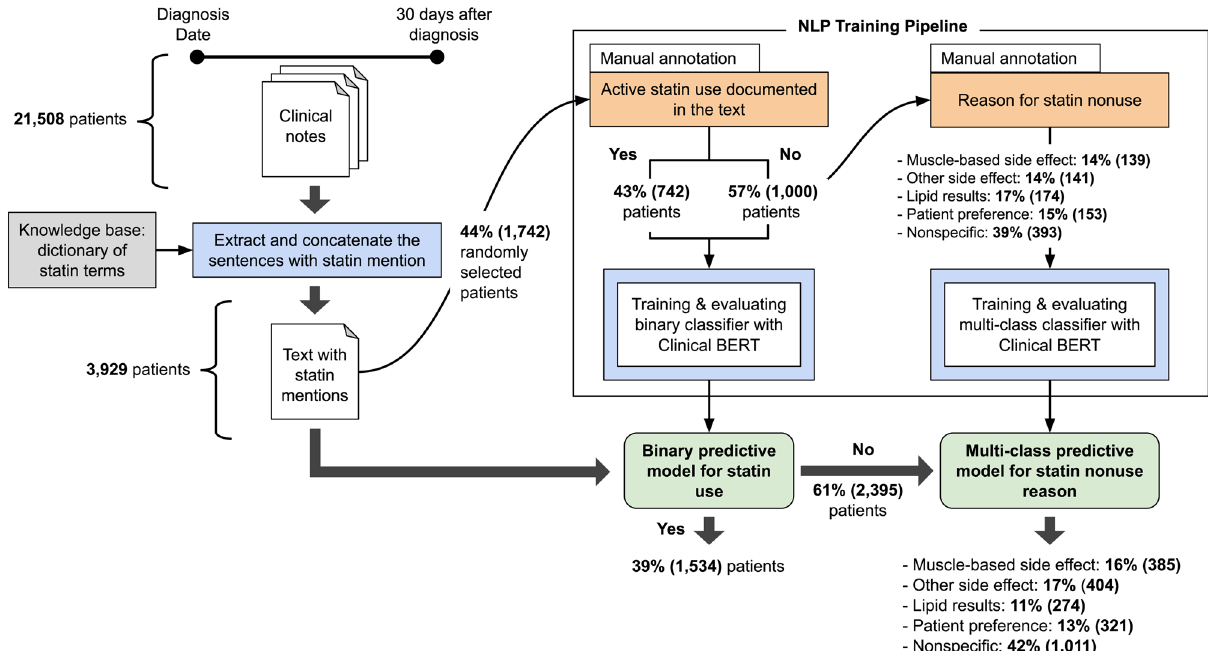
Fig. 2 Training, internal validation, and application of a deep learning model (Clinical BERT) for natural language processing to identify statin nonuse and classify reasons for statin nonuse from unstructured clinical notes of patients with ASCVD. Abbreviations: BERT Bidirectional Encoder Representations from Transformers, NLP natural language processing. Table 2 Performance of deep learning NLP models to characterize statin nonuse from unstructured clinical notes in persons with ASCVD.